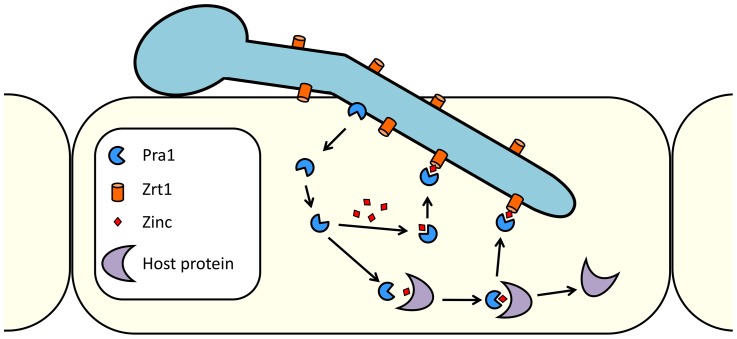
Model of C. albicans zinc scavenging from host cells.Following host cell invasion, Pra1 is expressed and secreted. The released fraction of Pra1 binds zinc, either directly from a cellular pool or from host zinc-binding proteins. Reassociation with the cell surface of C. albicans is mediated via direct Pra1-Zrt1 interaction.